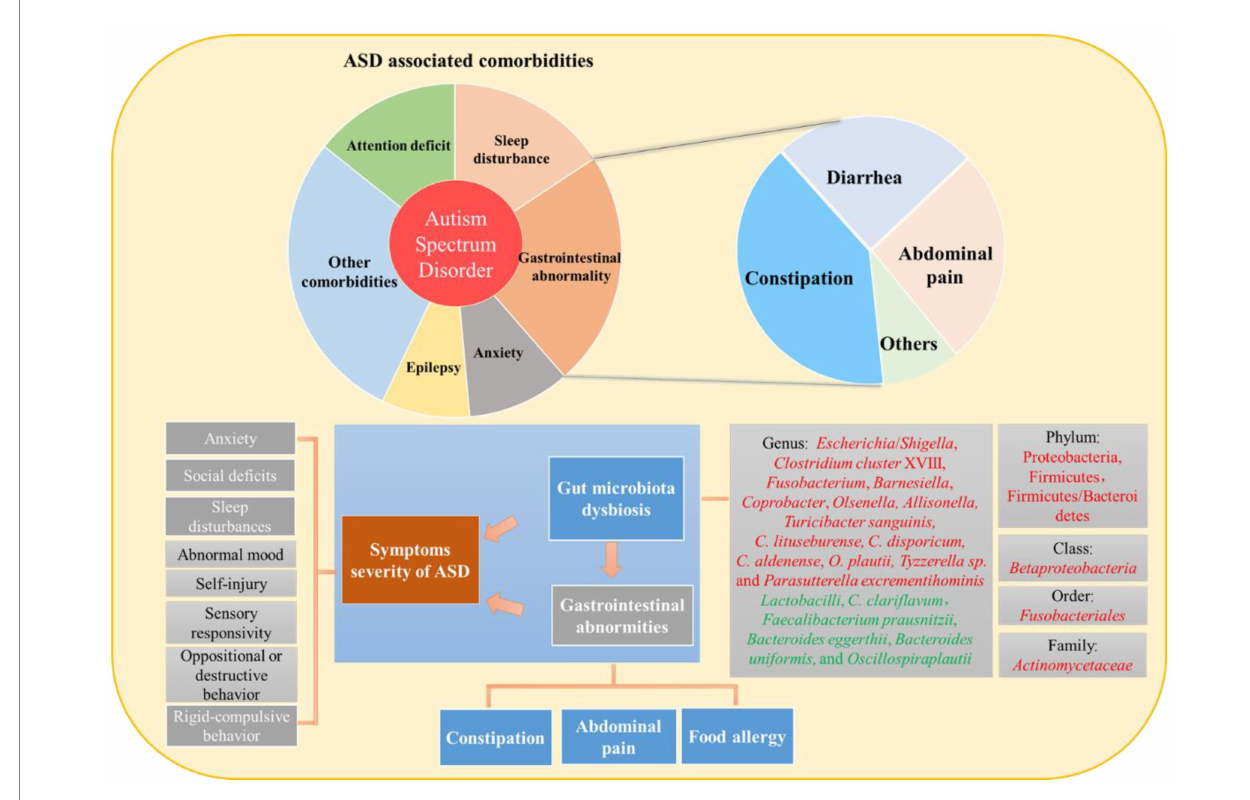
FIGURE 1 Interrelationship between gut microbiota dysbiosis, gastrointestinal abnormities, and symptoms severity of